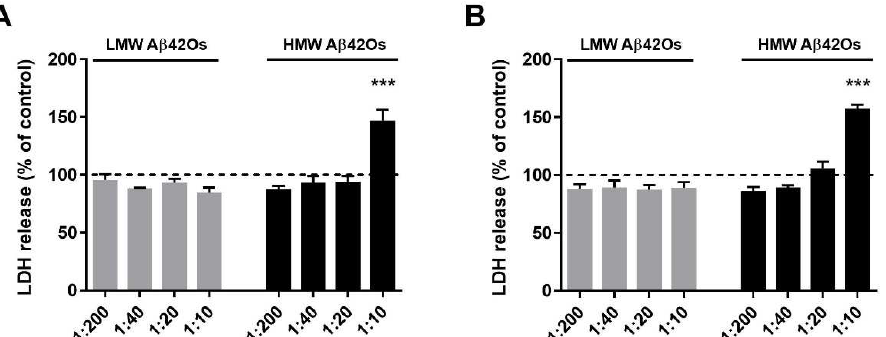
Figure 2. Effect of A β 42 oligomers on microglia cell viability. Microglia were cultured overnight in medium containing 10% serum, which was replaced with serum-free medium before treatment with vehicle, LMW or HMW A β 42Os for 24 ( A ) or 48 ( B ) h. At the end of incubation, cell viability was determined by LDH assay. Results are expressed as percentage of LDH release relative to control cells (dashed lines). Data are means ± SEM of 3 independent experiments, each performed in triplicate. *** p < 0.001 versus control cells. Two-way ANOVA, followed by Tukey’s multiple comparison test.